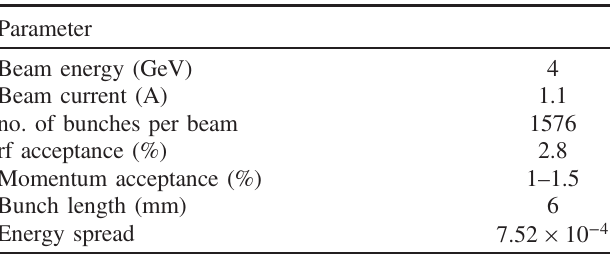
TABLE I. The parameters of the positron beam in the LER during phase I commissioning.